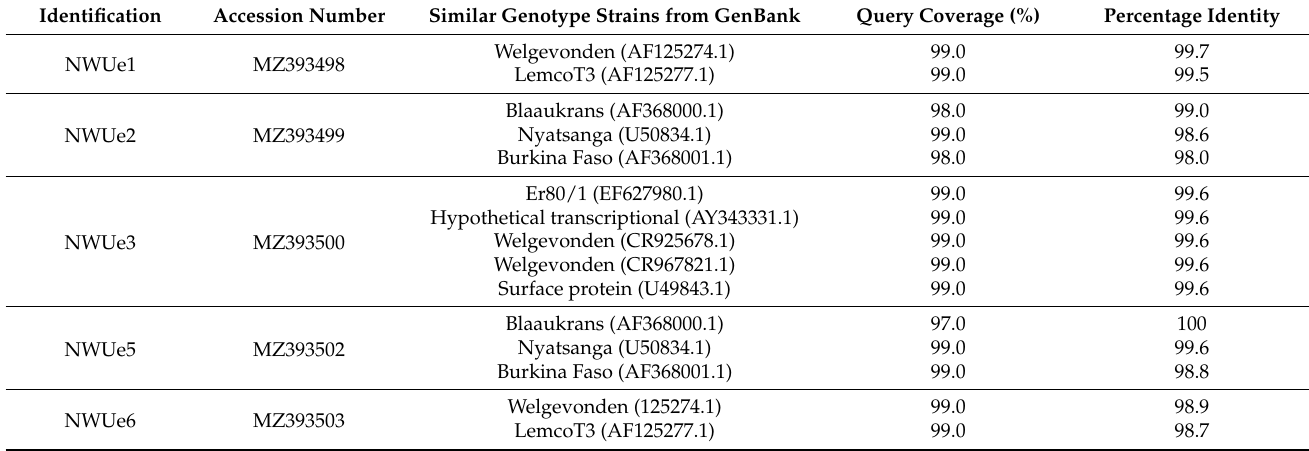
Table 3. Results of BLASTn from sequenced nested PCR Map1 gene